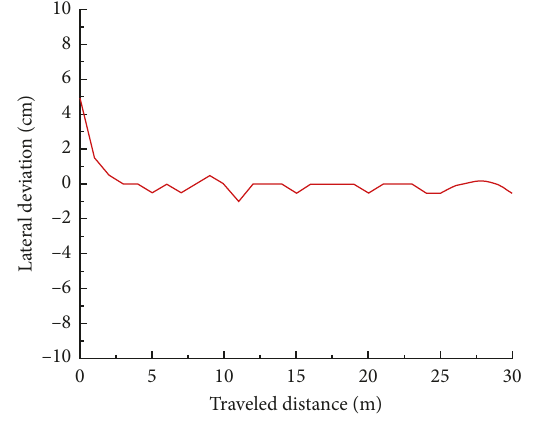
Table 3: Localization results from different